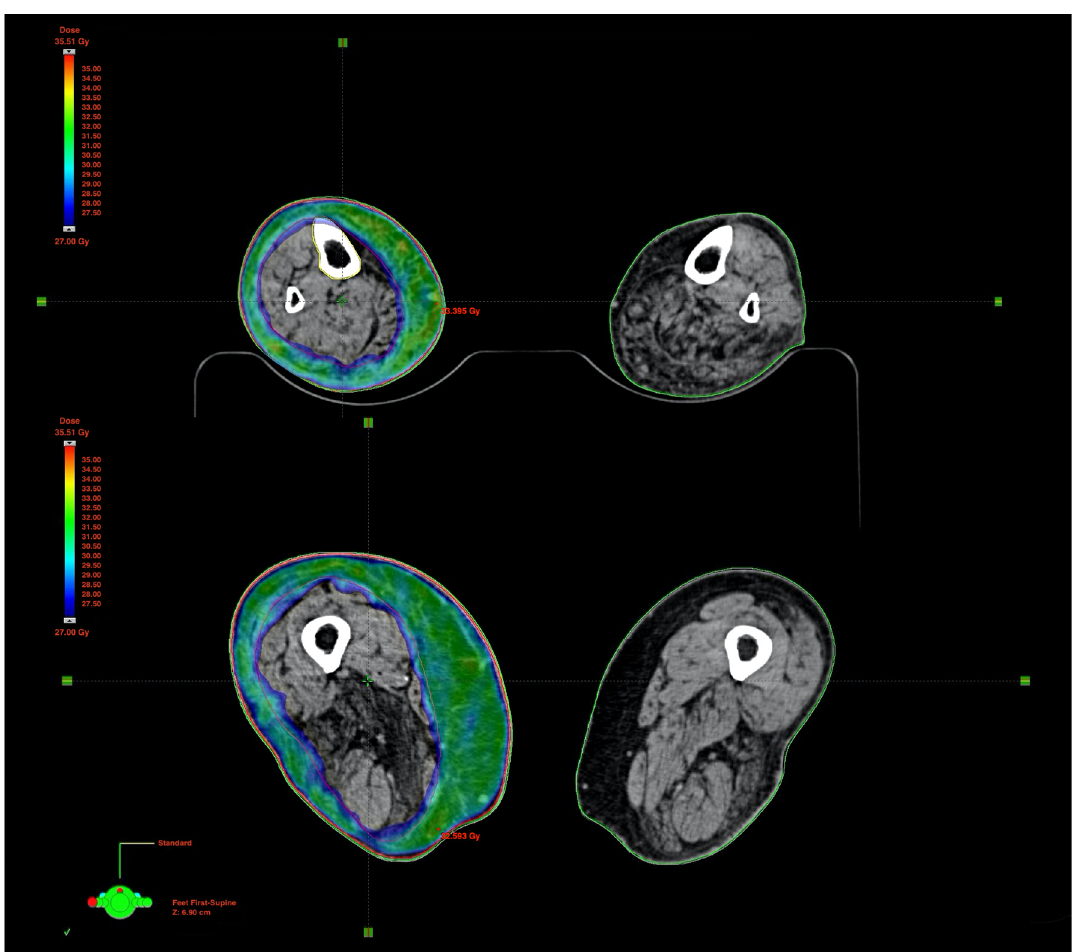
Figure 3. VMAT distribution curves of the 90% isodose covering PTV_leg ( top ) and PTV_thigh ( bottom ). VMAT, volumetric modulated arc therapy; PTV, planning target volume.